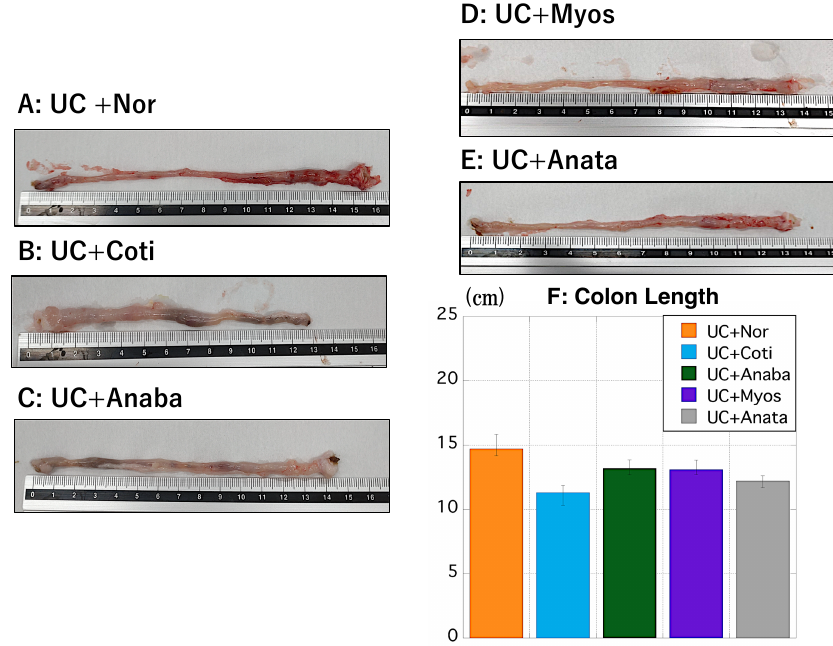
Figure 4. Changes in the colon length in the UC + Nico analog groups. ( A – E ) Images of the longest colon tissue in the UC + Nor, UC + Coti, UC + Anaba, UC + Myos, and UC + Anata groups. ( F ) The y -axis indicates the colon length (in cm) of rats in the UC + Nor (yellow), UC + Coti (light blue), UC + Anaba (green), UC + Myos (purple), and UC + Anata (gray) groups after initiating the experiment. Data values are presented as the median ± max/min. Nico, nicotine; UC, ulcerative colitis. Anaba, anabasine; Anata, anatabine; Coti, cotinine; Myos, myosmine; Nico, nicotine; Nor, nornicotine; and UC, ulcerative